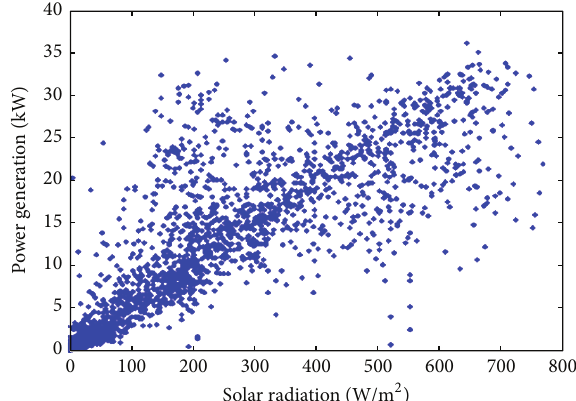
Figure 2: Photovoltaic power generation recorded at Taichung Thermal Power Plant in Taiwan.